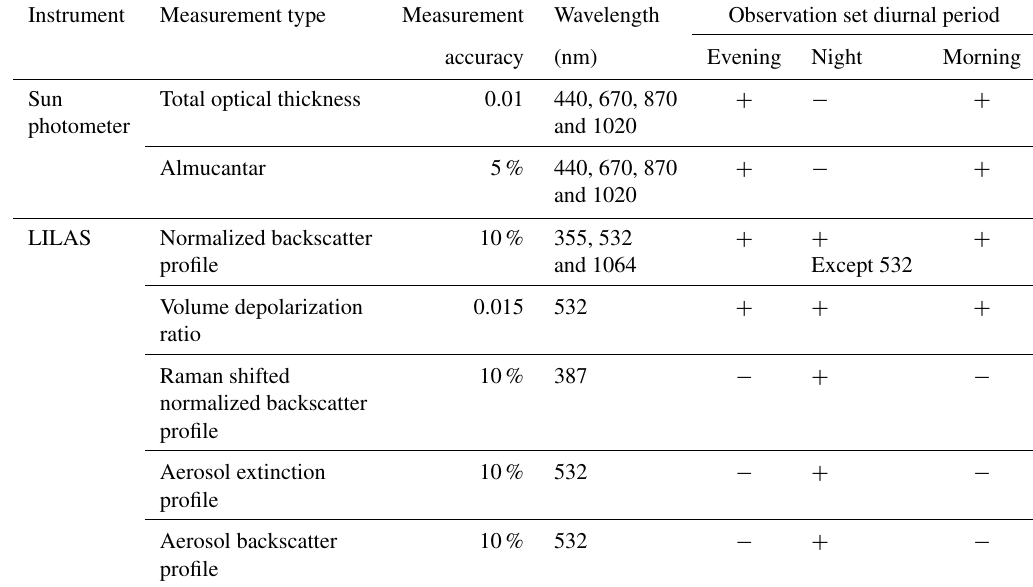
Table 4. Summary of the data and their combinations used by GRASP implying advanced multi-temporal retrieval scheme for SHADOW